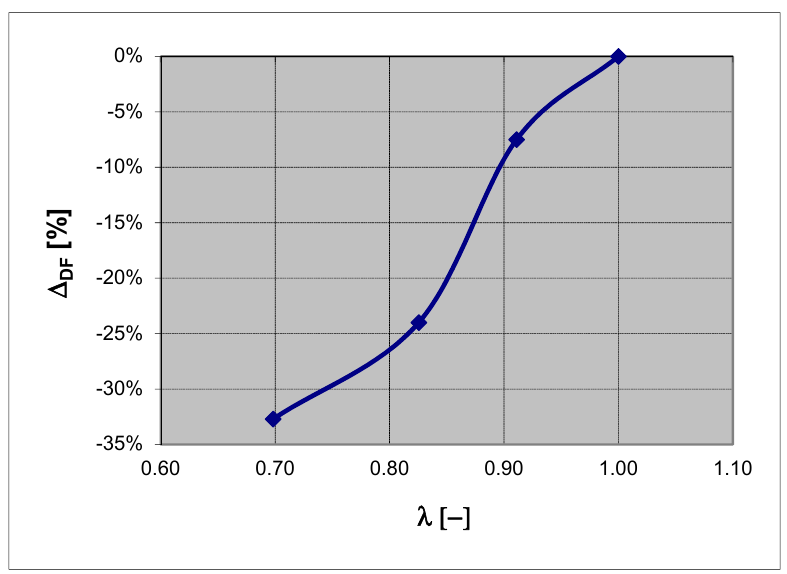
Figure 1. Error in determining the dilution factor DF depending on the λ [8].